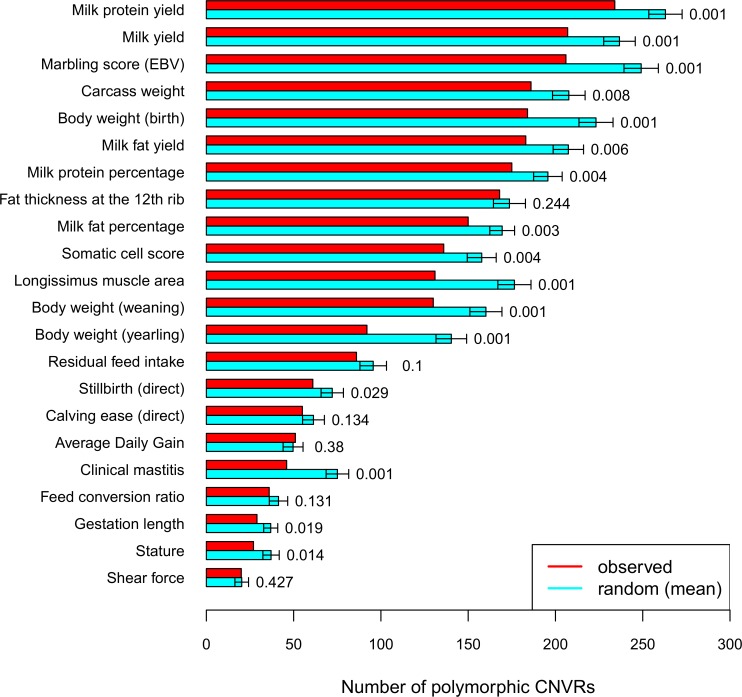
QTL-traits that overlap with polymorphic CNVRs in the Nelore population.Depicted are the most frequently overlapped traits. Red bars correspond to the observed number of polymorphic CNVRs overlapping with the respective trait, and cyan bars indicate the mean overlap when sampling 1000x random regions matching the polymorphic CNVRs in size and chromosomal location. The error bars indicate the standard deviation and permutation p-values are listed on the right.